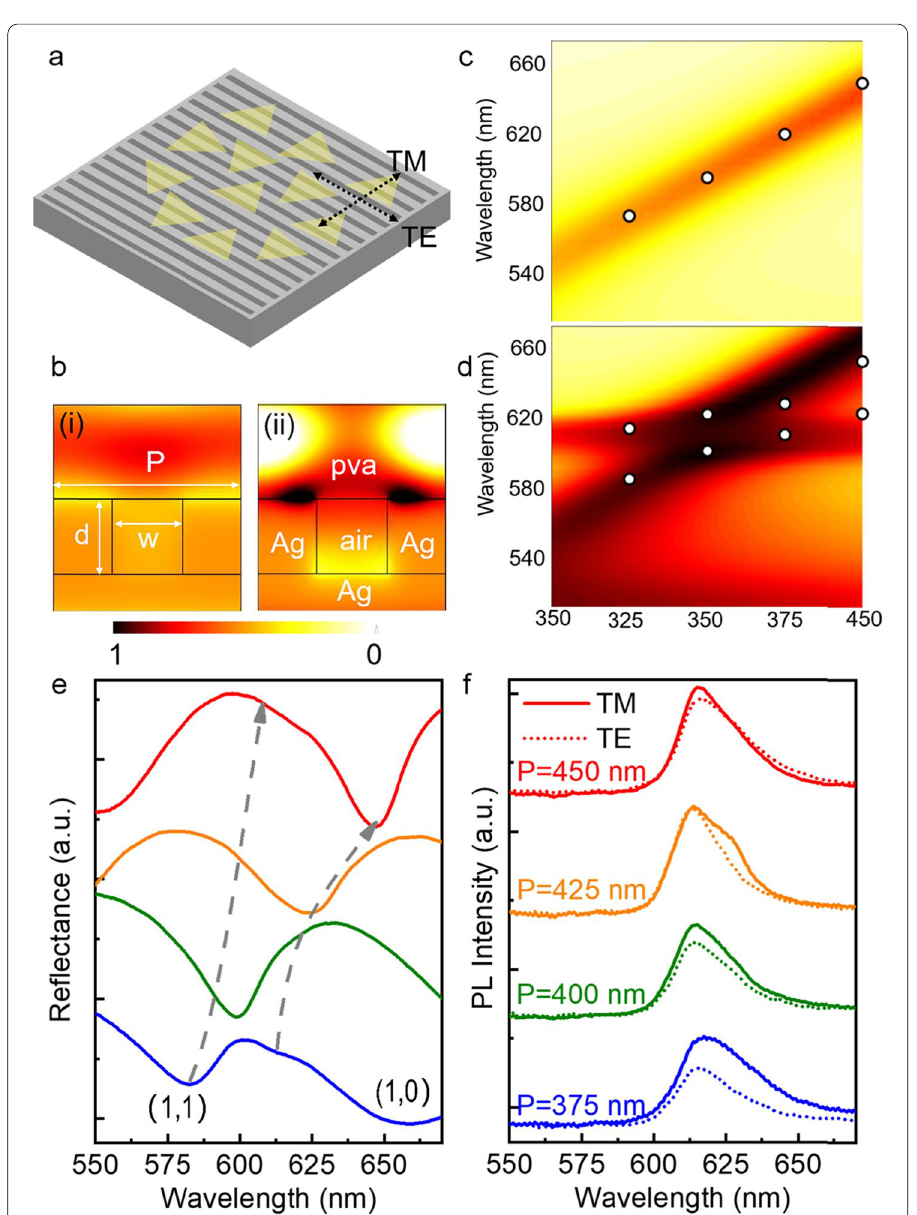
Fig. 1 Modulation of the WS 2 ‑linear Ag grating strong coupling device. a Schematic diagram of WS 2 ‑linear Ag grating device. b Electric field distribution of the linear Ag gratings with 400 nm period in TE (i) and TM (ii) mode at 617 nm. c , d Simulated reflection spectra of the linear Ag gratings ( c ) and monolayer WS 2 ‑linear Ag gratings ( d ) with different periods in TM mode. The relevant experimental data are marked with white open circles. e Reflection spectra of the WS 2 ‑linear Ag grating devices in TM mode. f PL spectra of the WS 2 ‑linear Ag gratings devices in TE (dotted line) and TM (solid line)